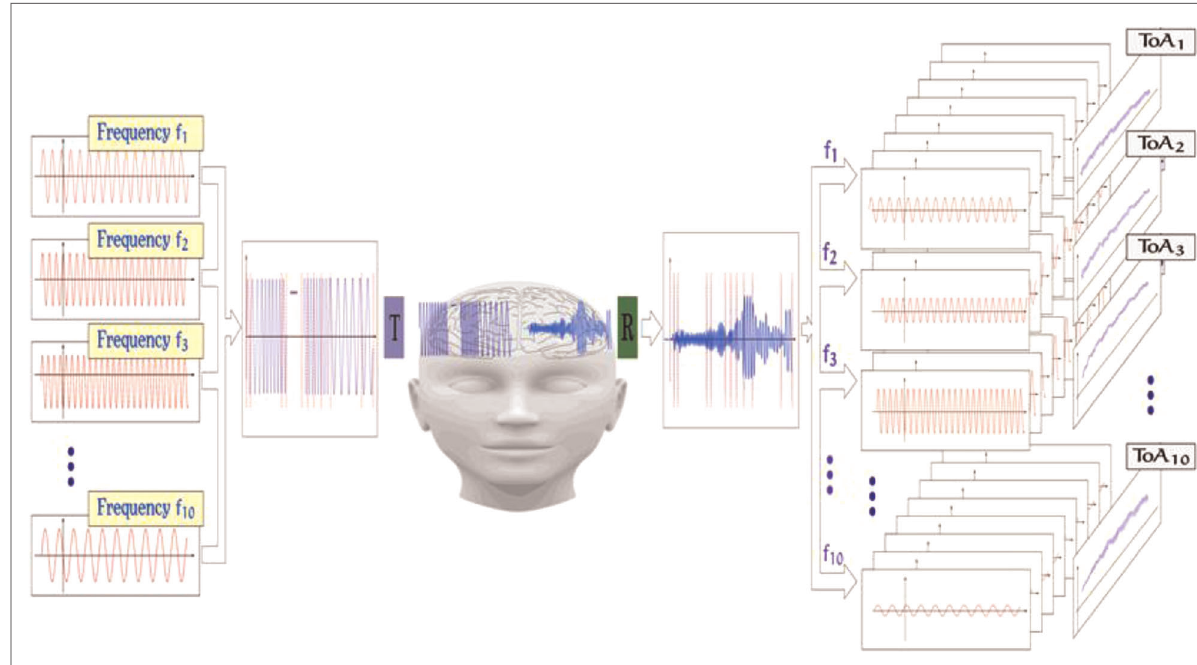
FIGURE 2 Signal acquisition method of the ACG; from left to right: different frequency components in the range of 0.5 – 2.5 MHz are chosen, and an input signal is formed by either concatenating the frequency packages or by superposition of those. The signal is then emitted from an ultrasound transducer and propagated through the brain. The complex ultrasonic signal is then received and sampled on the other side of the skull. By comparing both input and output signals, features like, for example, TOF and signal ATT are